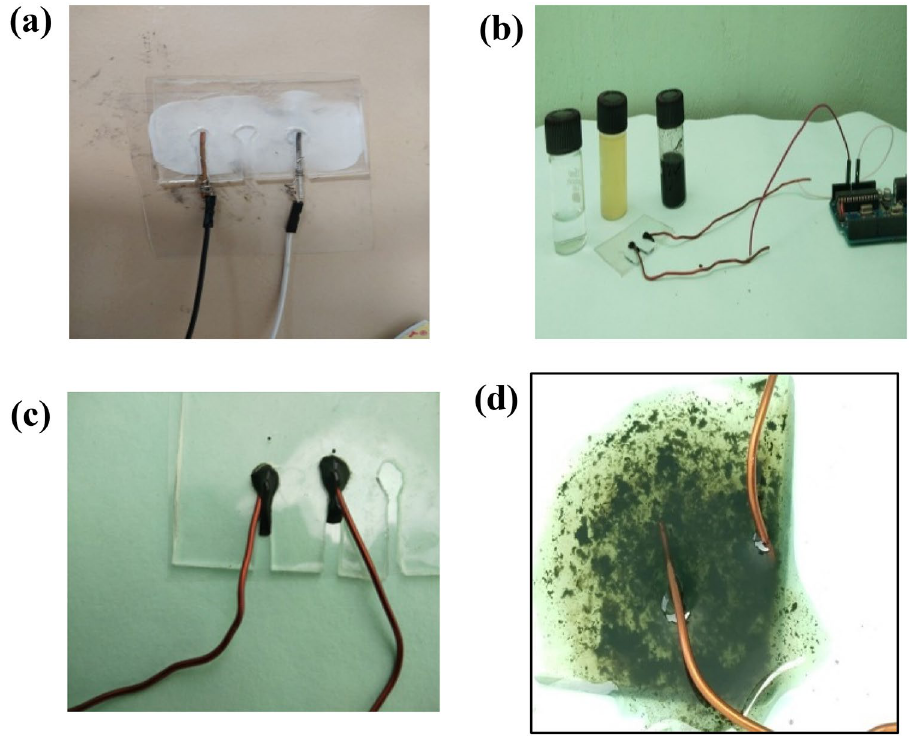
Figure 4. Experimental setup comprising of the following: ( a ) Hydrophobic testing of the sensor base; ( b ) PC-based analysis of normal water samples; ( c ) Voltage measurements with Cu electrodes; ( d ) E. coli samples inoculated in f GO